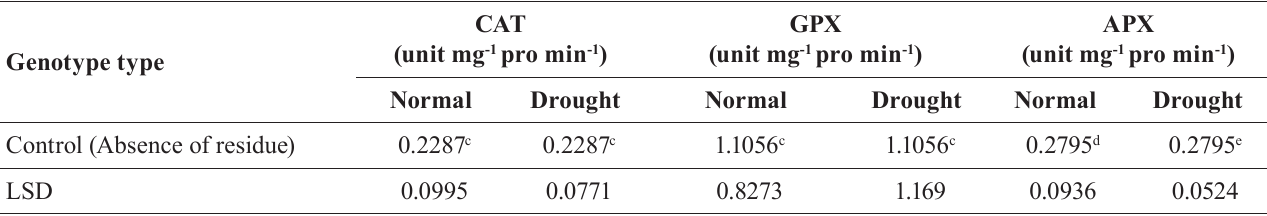
TABLE III - Mean comparison for antioxidant activities of radish seedlings affected by allelopathic potential of safflower root residue grown under normal irrigation and drought stress